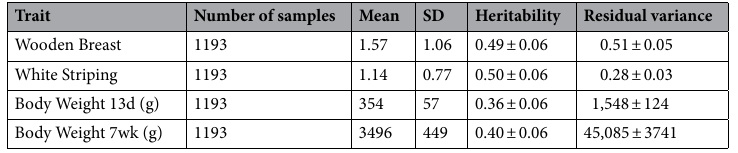
Table 1. Trait statistics and estimates (± SE) of heritability and residual variance from univariate analyses of wooden breast, white striping, and body weight at 13 days and at 7 weeks of age. Wooden breast was scored on a 5-point scale from 0-Normal to 4-Severe. White striping was scored on a 4-point scale from 0-Normal to 3-Severe.